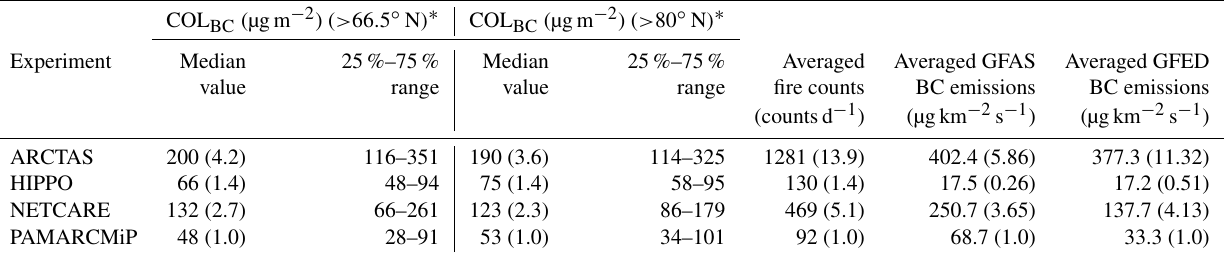
Figure 2. (a) Vertical profile of the BC mass concentration ( M BC ) observed during the PAMARCMiP aircraft-based field experiment. Closed circles denote 1min data. Median values and 25%–75% ranges are also shown. Data points shown in red (enhanced M BC data points) were likely influenced by biomass burning emissions and are discussed in Sect. 5. (b) Vertical profiles of median M BC values observed during the aircraft-based experiments made over the Arctic ( > 66 . 5 ◦ N) in spring (Table 3). Table 4. Column BC amounts and biomass burning